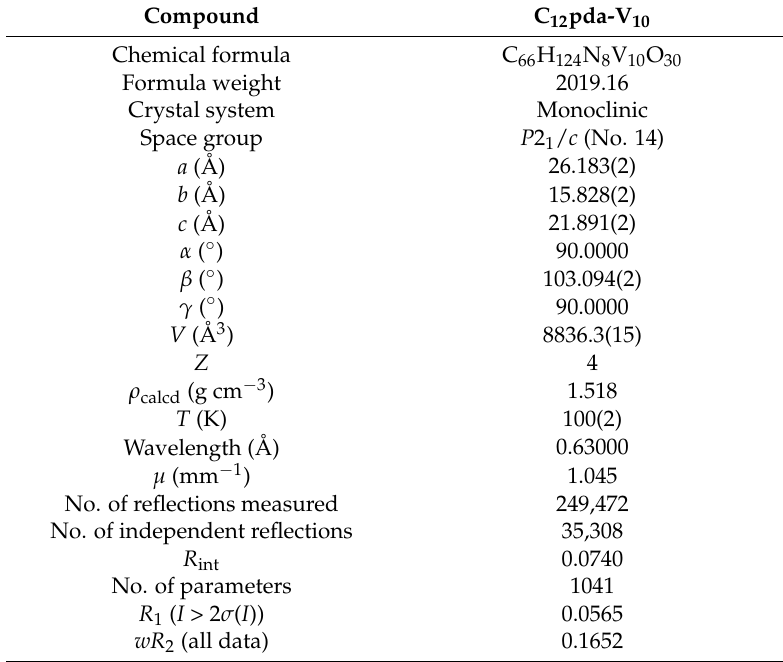
Table 1. Crystallographic data of C 12 pda-V 10